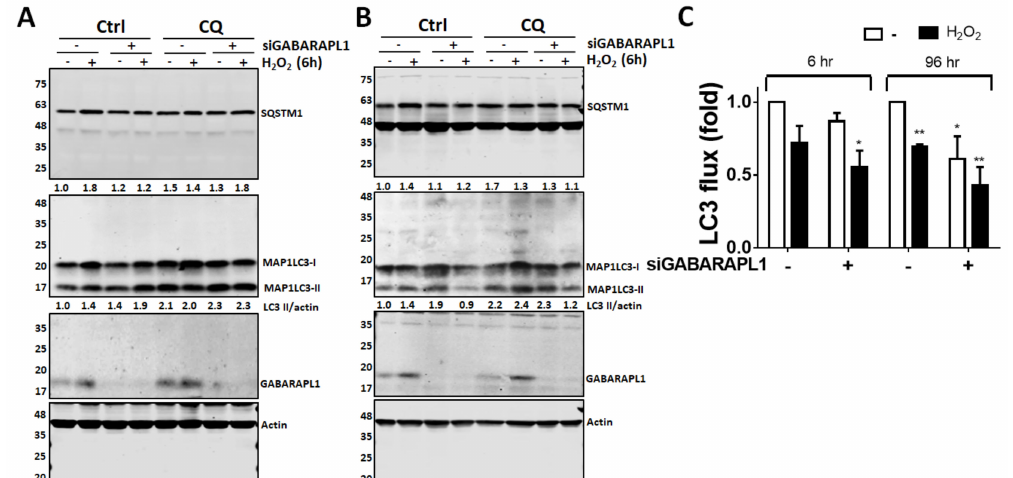
Figure 4. The effect of GABARAPL1 on autophagic flux in ARPE-19 cells exposed to oxidative stress. ARPE-19 cells were transfected with 5 nM of siRNA against GABARAPL1. The cells were then exposed to 250 µ M of H2O2 for 6 h ( A ) or 96 h ( B ). The cells were lysed for Western blots using an antibody against MAP1LC3B to analyze the autophagic flux level. Molecular weight is shown in the left-hand side of the blot. ( C ) The quantitative results of autophagic flux in ARPE19 during oxidative stress are shown as the mean ± SD from three independent experiments. * p < 0.05, ** p < 0.01 vs. cells with non-targeting control siRNA ( − ) and without H 2 O 2 ( −